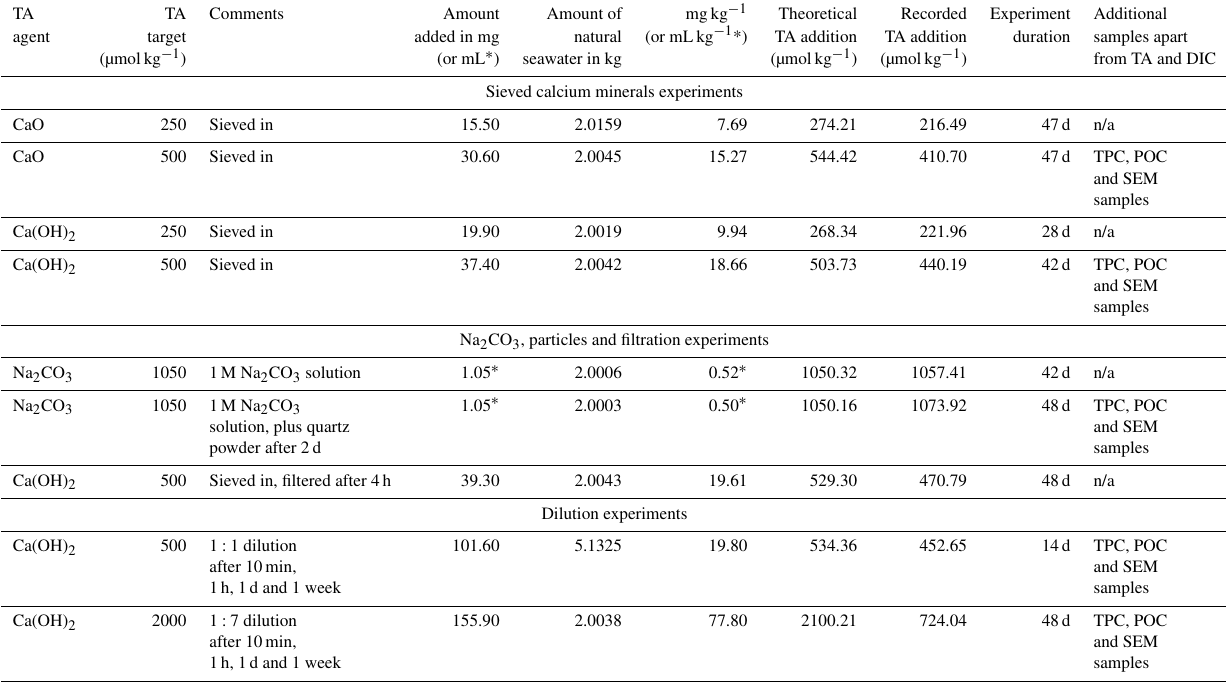
Table 1. Summary of experimental conditions. Please note that for comparability, more TA was added in the liquid than the sieved approaches to match the theoretical increases in calcium carbonate saturation state (see “Materials and methods” section for details). TA TA